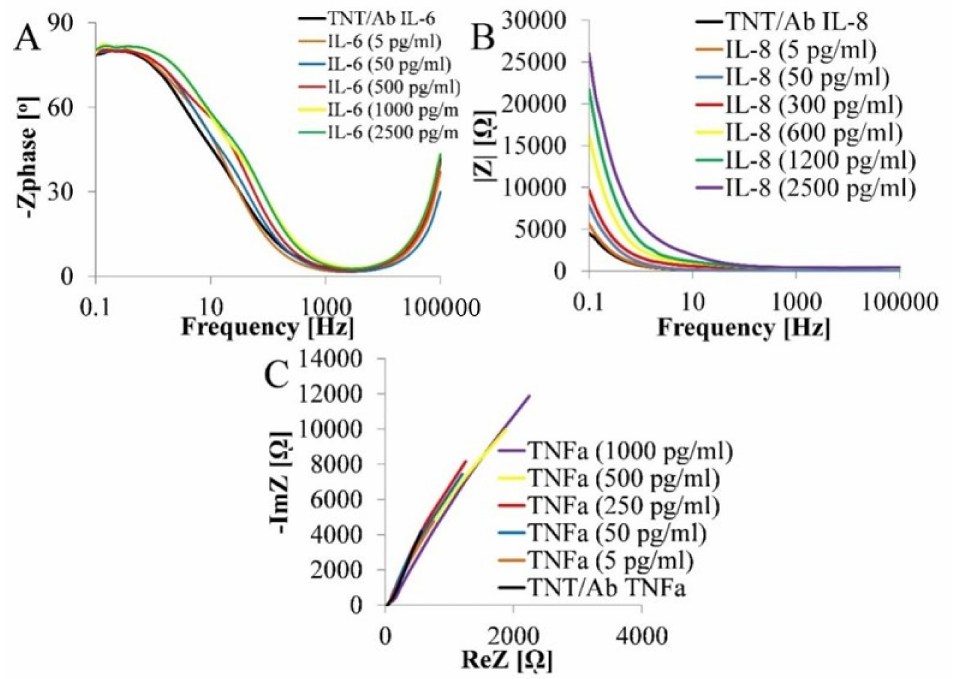
Figure A1. Impedimetric response studies of TNT immunoelectrode incubated with di ff erent concentration of IL-6, IL-8, TNF α , presented in Bode representations for IL-6 ( A ) and IL-8 ( B ) and in Nyquist representation for TNF α ( C